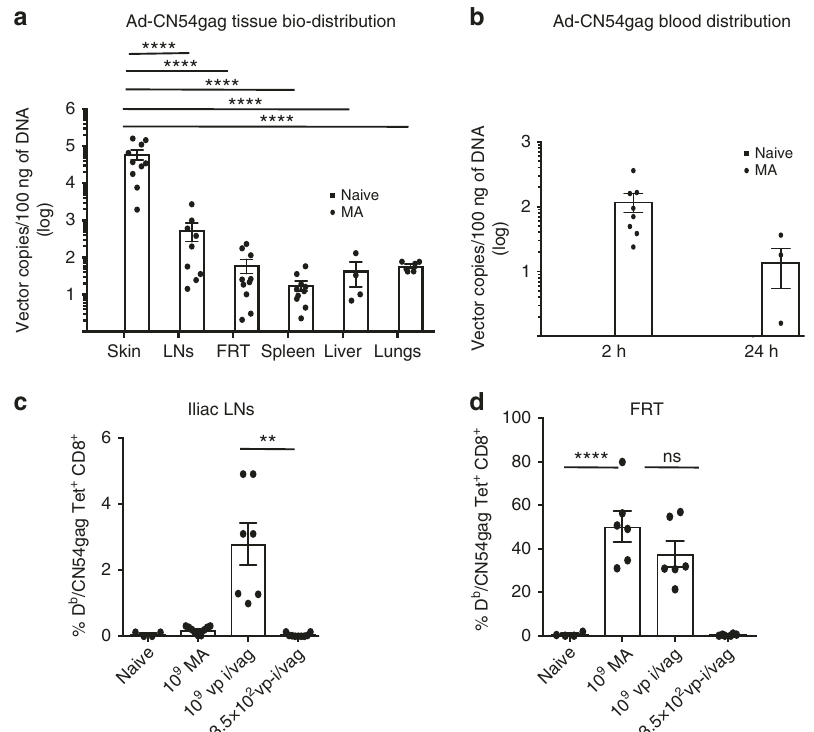
Fig. 3 Biodistributed rAd5 vaccine vector does not prime CD8 + T cells in FRT or iliac LNs. a Quanti fi cation of Ad vector genomes by qPCR sequestered in indicated organs at 24 h post MA immunisation with Ad-CN54 gag (1 × 10 9 vp). b Ad vector genomes quanti fi ed in whole blood at 2 and 24 h post skin (MA) immunisation with Ad-CN54 gag (1 × 10 9 vp) ( a , b ). Data are from two independent experiments ( n = 4 – 10 per group). c , d Frequencies D b /CN54 gag tet + CD8 + T cells in FRT tissue and iliac LNs after skin (MA) or intravaginal immunisation with Ad-CN54 (1 × 10 9 vp) or with the vector dose (3.5 × 10 2 vp) equivalent to the copy number detected by qPCR in FRT after skin immunisation. Data ( n = 4 – 9 per group) are from three independent experiments. P >0.05 (ns), ** p < 0.01, *** p < 0.001 by one-way ANOVA, error bars show